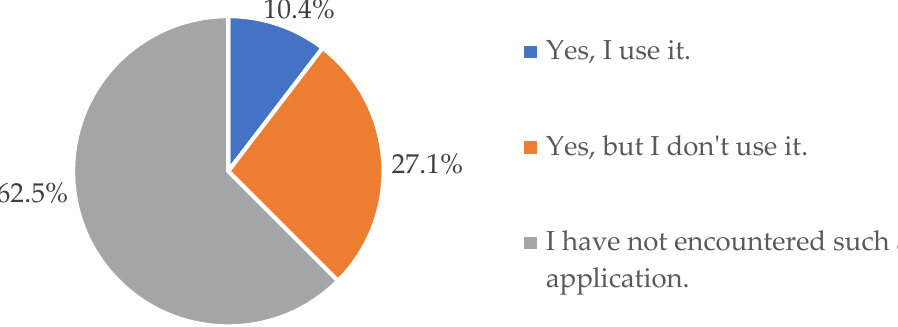
Figure 10. Distribution of students according to whether they had ever encountered an environmental, renewable energy app (%).